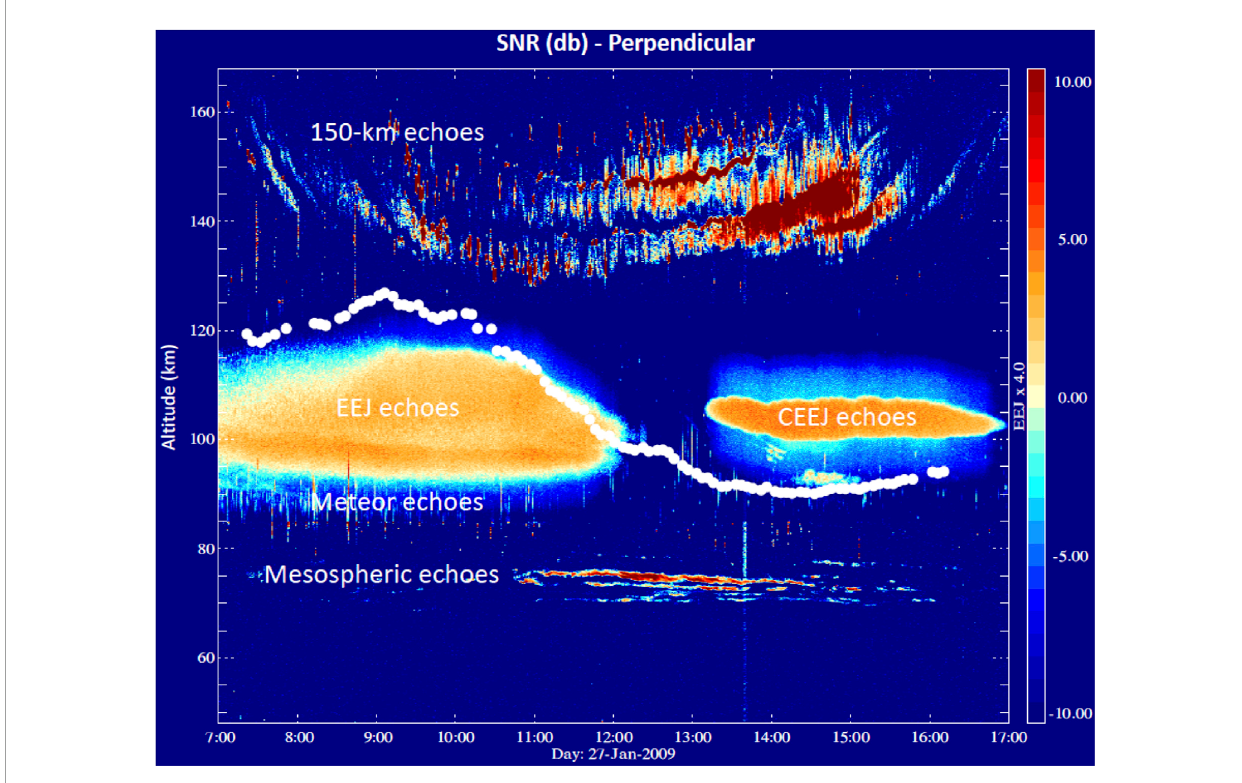
FIGURE 1 Example of an altitude-time signal-to-noise ratio (SNR) of targets over Jicamarca between 65 and 170 km during daytime on 27-January-2009, i.e., 150-km, normal (EEJ) and counter (CEEJ) equatorial electrojet, and mesospheric echoes. The mean vertical E × B drift from 150-km echoes is overplotted in white (see scale to the right multiplied by 4) (adapted from Reyes et al., 2020, Figure 1).